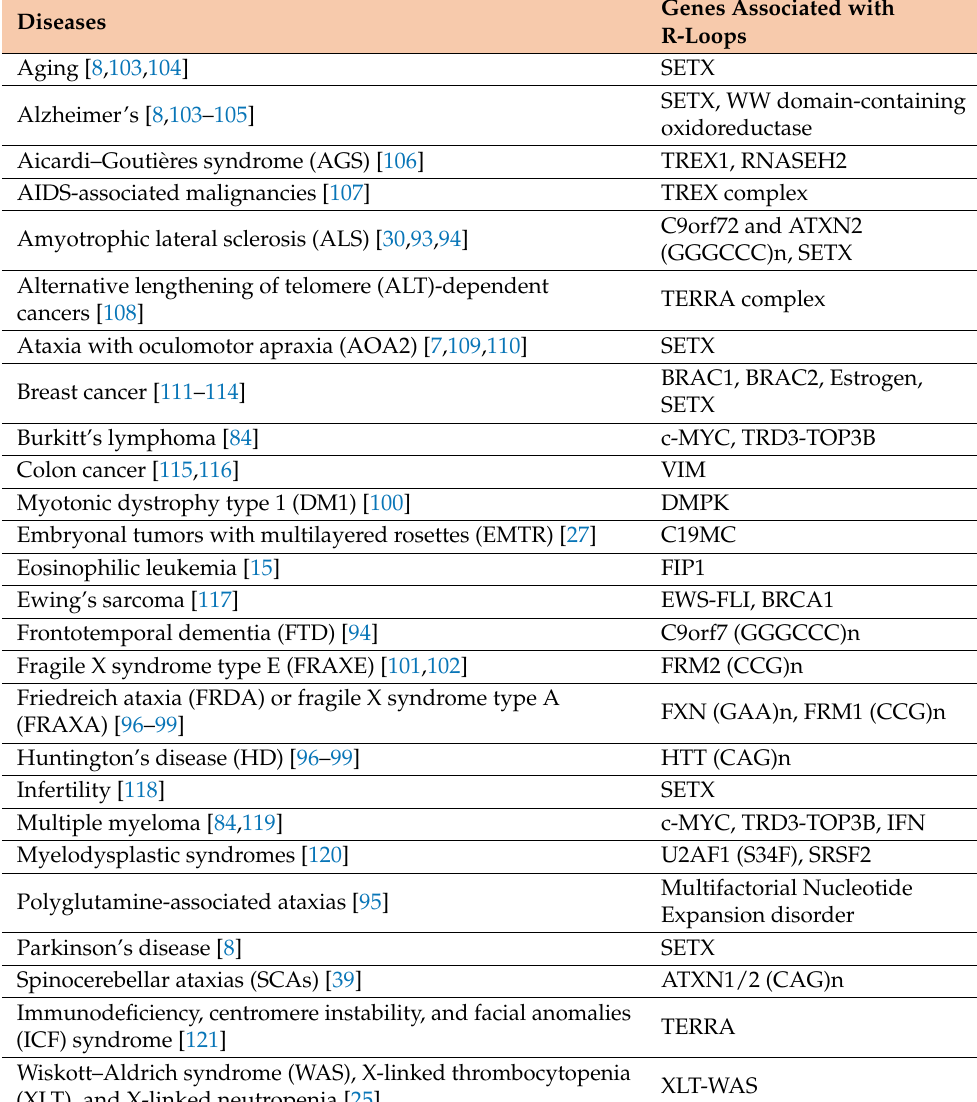
Table 3. R-Loop-linked diseases and genes associated with aberrant R-loop